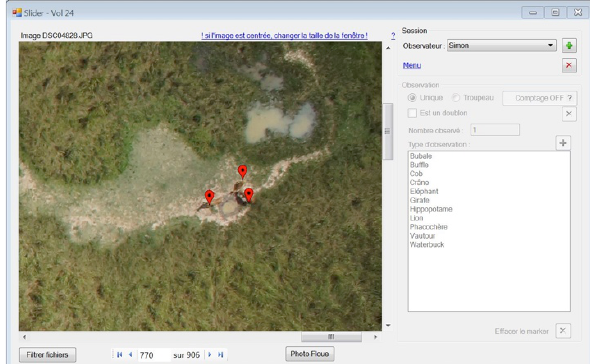
Figure 7. Three kobs marked by observer 3 using the detection and count tool. Each observer has his own set of observations and can add it by simply double-clicking on the photo Three observers reviewed the six flights and results of their observations totalized for each complete inventory are displayed in Table 8. They spotted buffaloes, hippos, warthogs and various antelopes with different success over an average rate of 8 images reviewed per minute. Resulting mean densities vary a lot between the two trials (23,8 and 6,5 animals/km 2 respectively) but stay close enough for the three observers for each (coefficient of variation 6,9 and 8,6% respectively). After revision of all the differences, a new, more accurate count was produced that gives densities of 25,0 and 8,2 animals/km 2 .